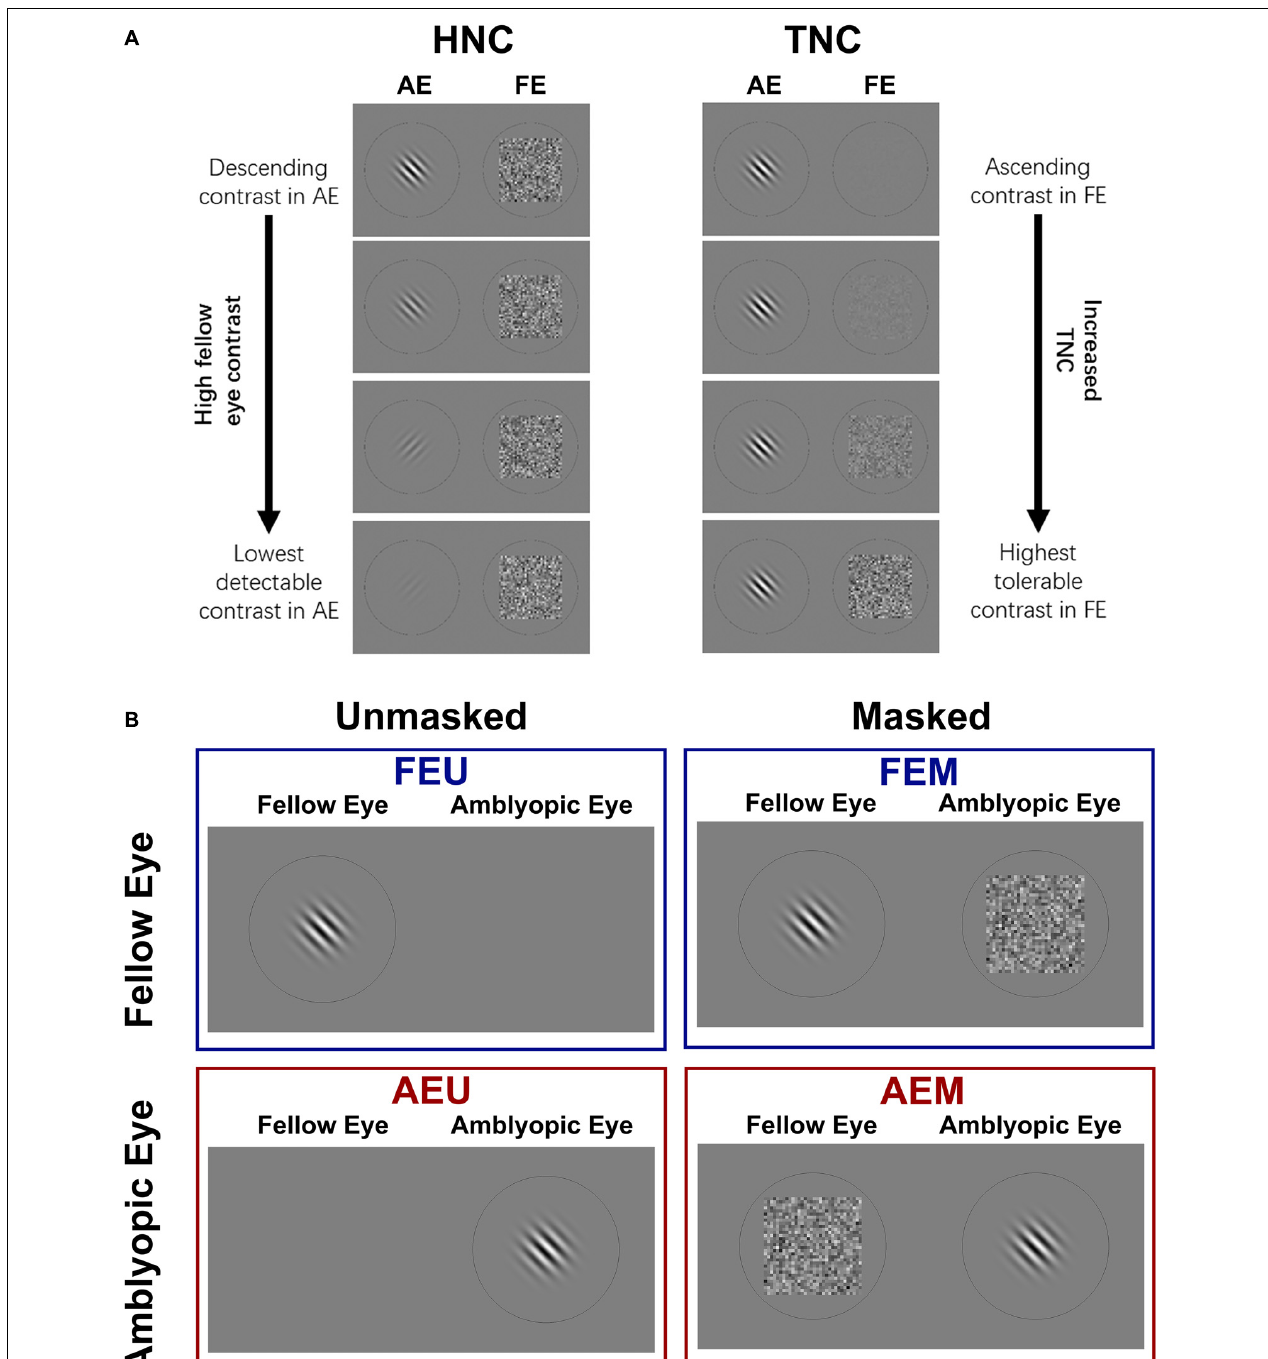
FIGURE 1 | (A) Two strategies of dichoptic training used in this study. Left: High noise contrast (HNC) protocol; Sinusoidal gratings were presented to one eye, while a mean background luminance (monocular unmasked condition) or a Gaussian white noise mask (dichoptic masked condition) was presented to the untested eye. From top to bottom: the contrast of gratings in an amblyopic eye (AE) was manipulated from high to low, while noise mask in a fellow eye (FE) was fixed at high contrast ( σ = 0.33). With training, the contrast of grating was adjusted (usually decreased) to maintain stable performance. Right: tolerable noise contrast (TNC) protocol; grating contrast in AE was fixed while mask contrast in FE was manipulated from low to high to maintain stable performance. (B) Four conditions of CSFs were measured: unmasked fellow eye (FEU), unmasked amblyopic eye (AEU), masked fellow eye (FEM), and masked amblyopic eye (AEM).